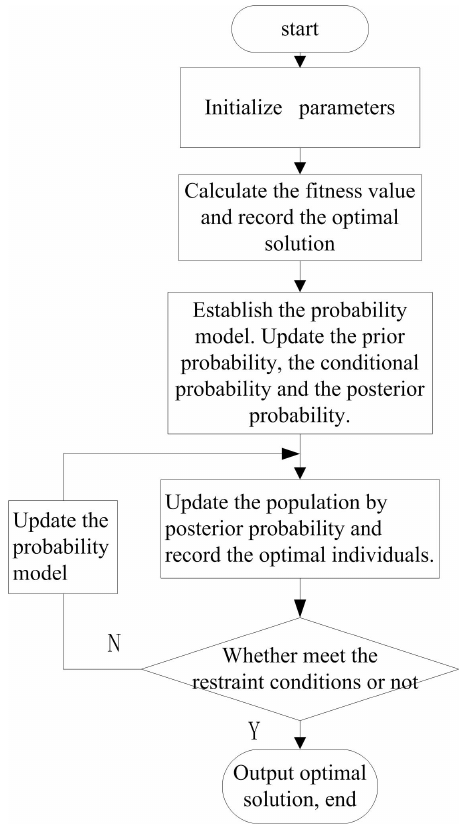
Figure 2. The flow chart of